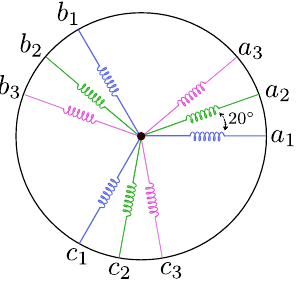
Figure 2. Asymmetrical representation of a nine-phase IM with 20 ◦ electrical displacement between the three-phase